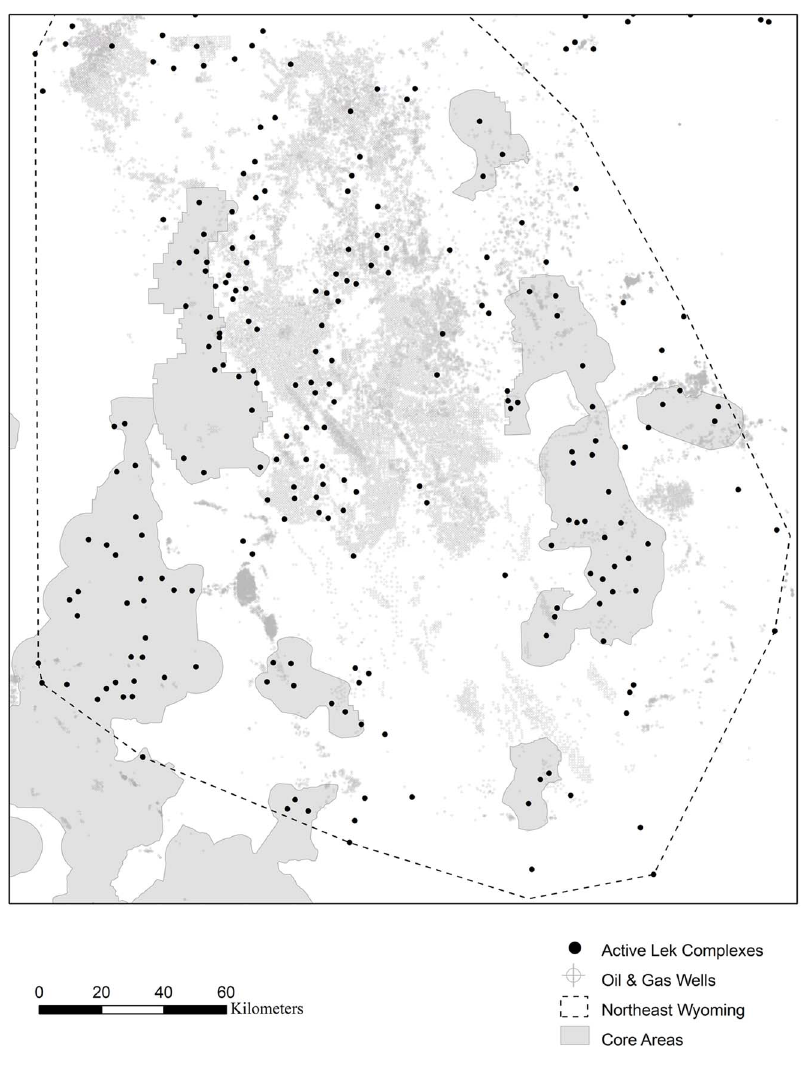
Figure 3. Northeast Wyoming leks, oil and gas wells and core sage-grouse management areas. As of 2009, the pictured leks were active and the pictured wells were producing.